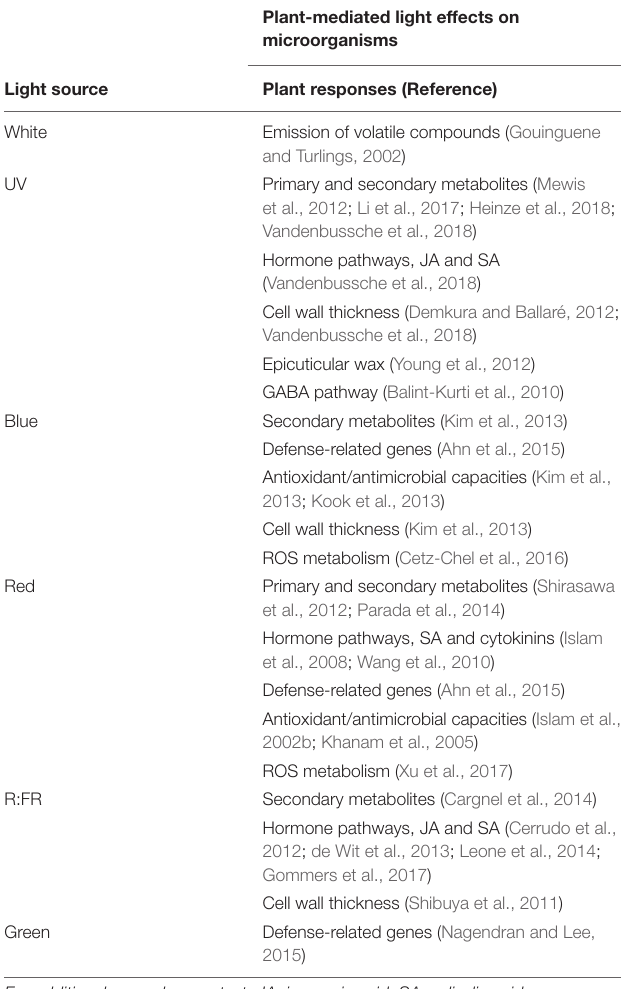
TABLE 3 | Plant-mediated light effects on plant–phyllosphere interactions, with examples of light-induced plant traits that affect microorganism behavior. Plant-mediated light effects on